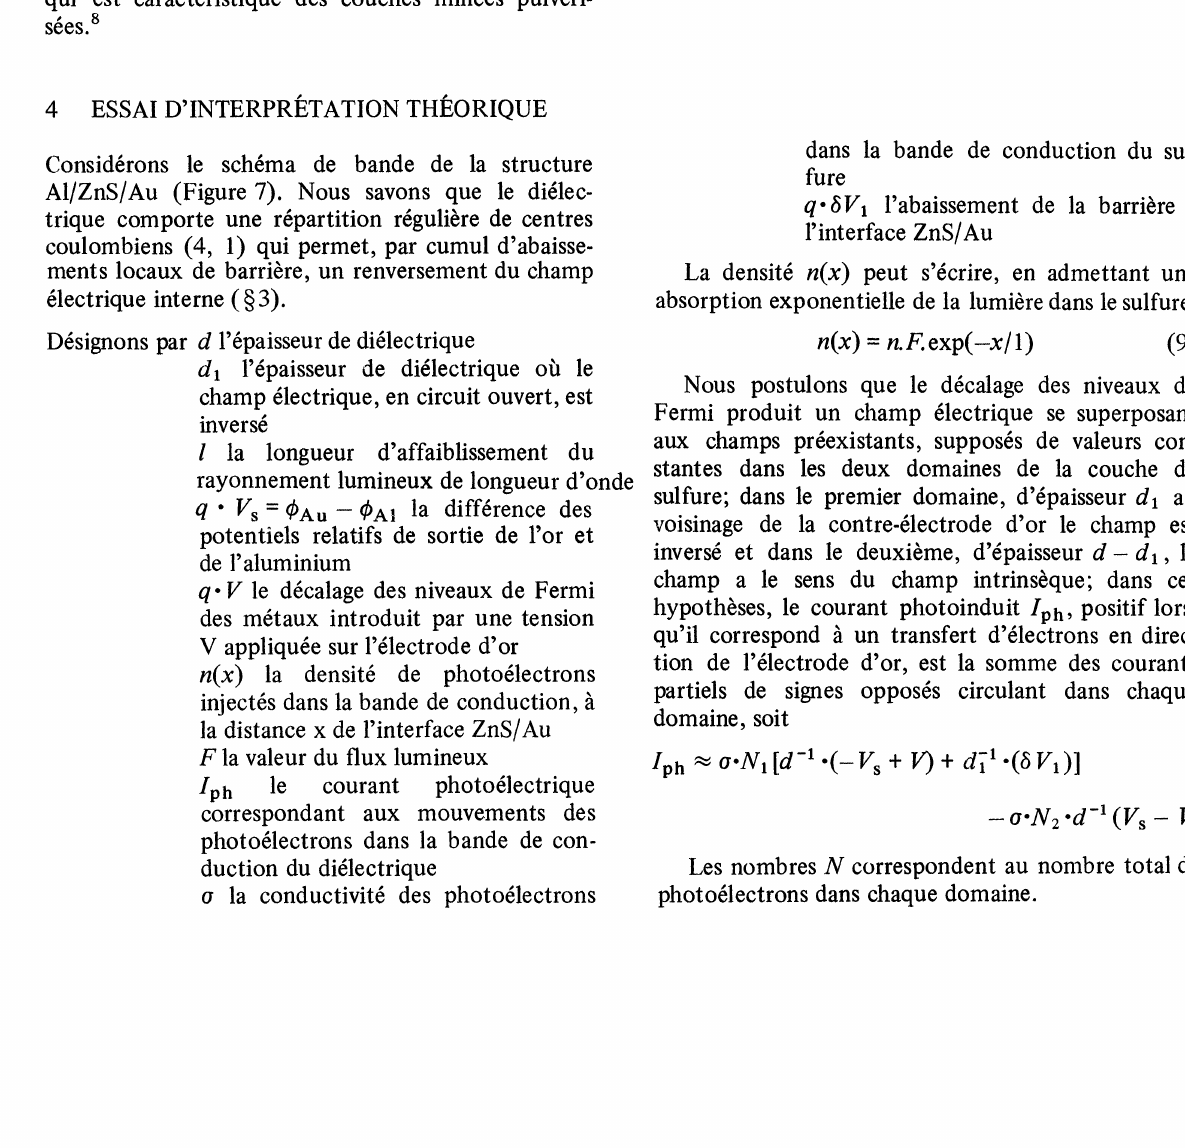
Mod[le de bandes simplifi des couches de sulfure de zinc: dans l’paisseur d la quasi-bande de conduction est inverse par rapport la bande de conduction suppose habituelle, qui est pratiquement inchange dans le reste du domaine d